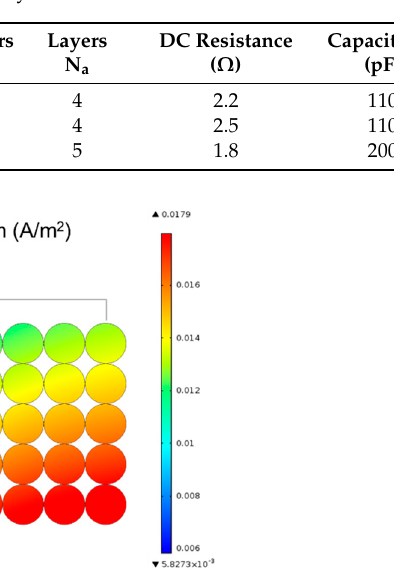
Figure 7. PTE calculated versus ( a ) transfer distance and ( b ) rotation angle in the simulation.